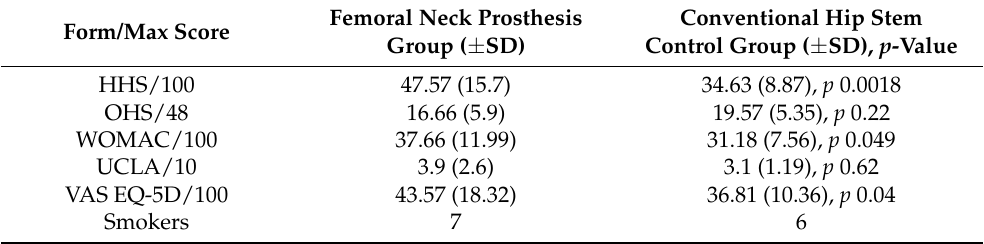
Table 2. Pre-operative form